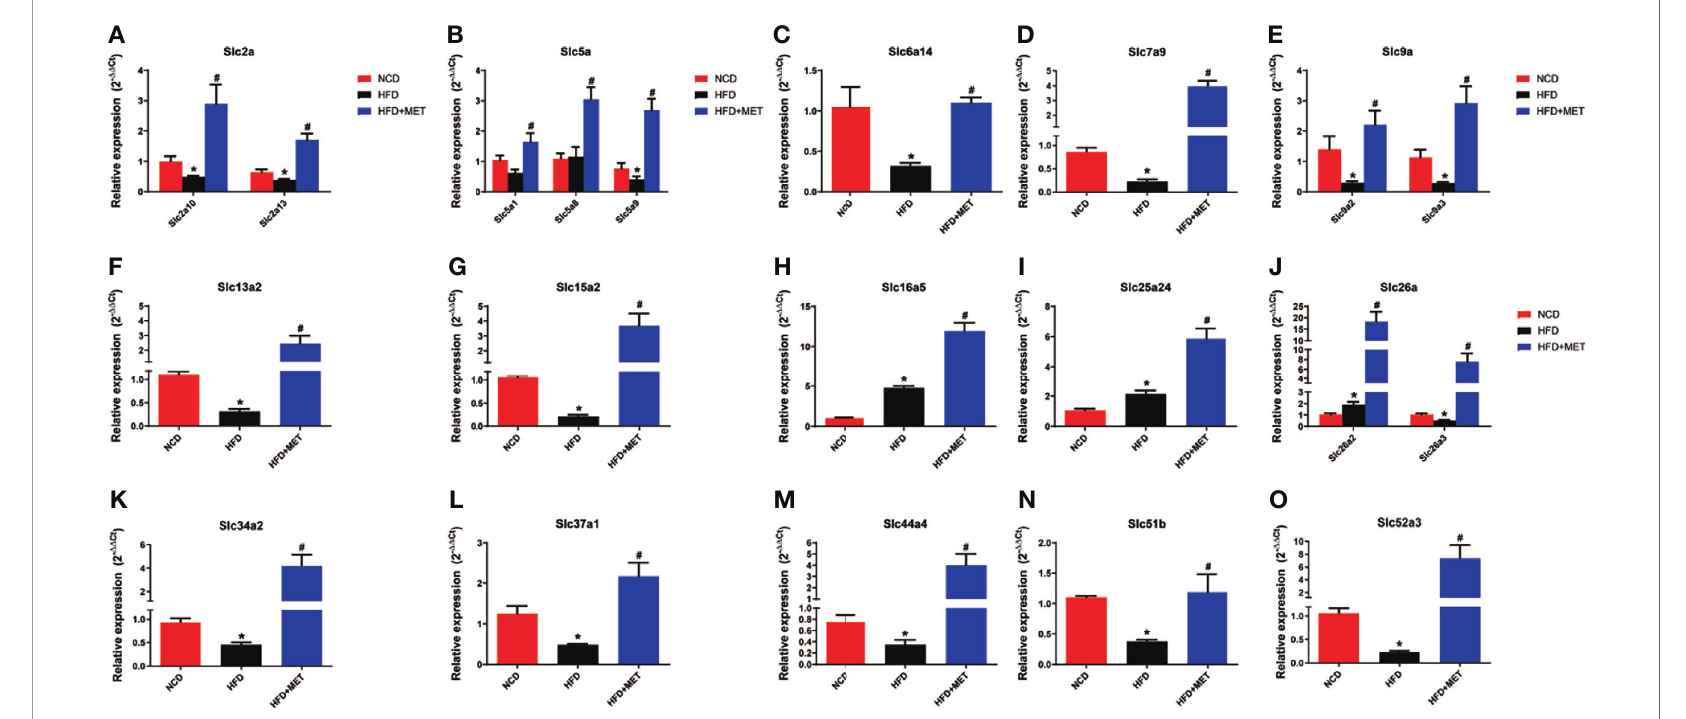
FIGURE 7 | Expression validation of the 20 MET-responsive Slc genes in liver via RT-qPCR. The mRNA levels of the 20 common Slc DEGs were validated by RT-qPCR (2 − DD CT method) (A – O) . The housekeeping gene GAPDH was used to normalize the relative expression level. Data are presented as the mean ± SEM (n = 3). * P < 0.05 HFD versus NCD, # P < 0.05 HFD+MET versus